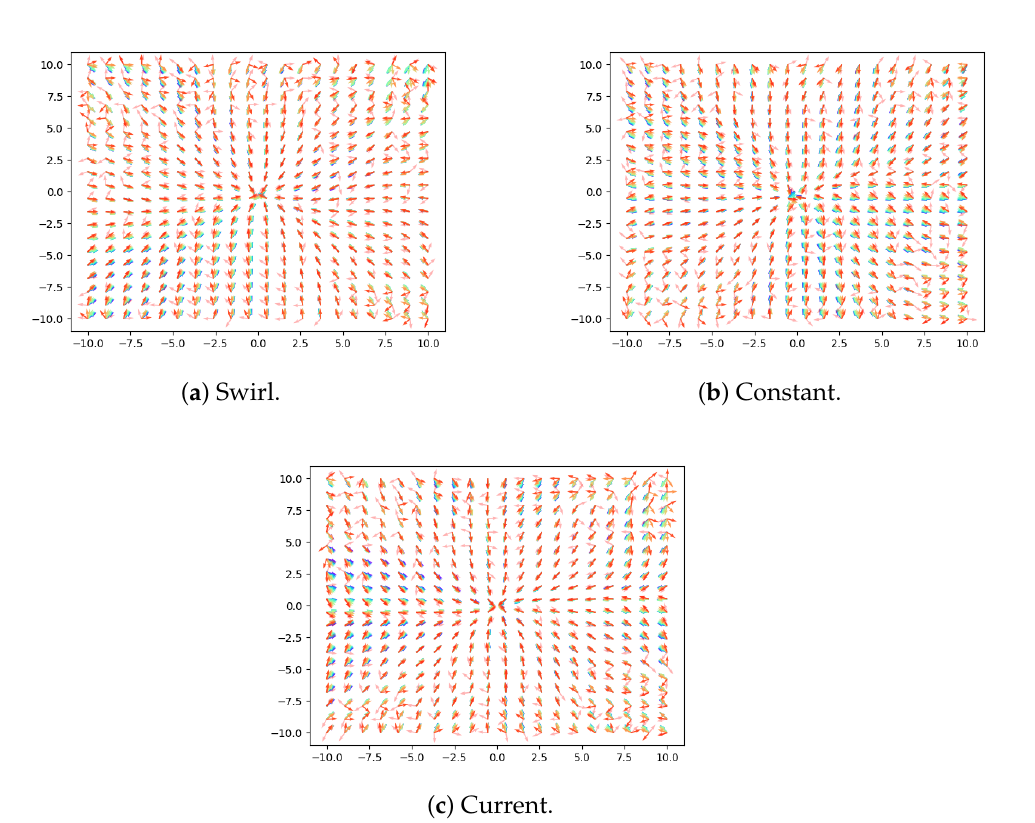
Figure 4. Control obtained by DGM for each disturbance, where the horizontal and vertical axes represent x and y , respectively, and considering that v x = v y = 0. Note that these plots represent the optimal control obtained using (15), which depends on the gradient of the value function from Figure 3. We represent the control for different values of t , where cold colors represent t t f . We observe that the quality of the control obtained by DGM worsens slightly as warm colors t → the distance from the origin increases, as